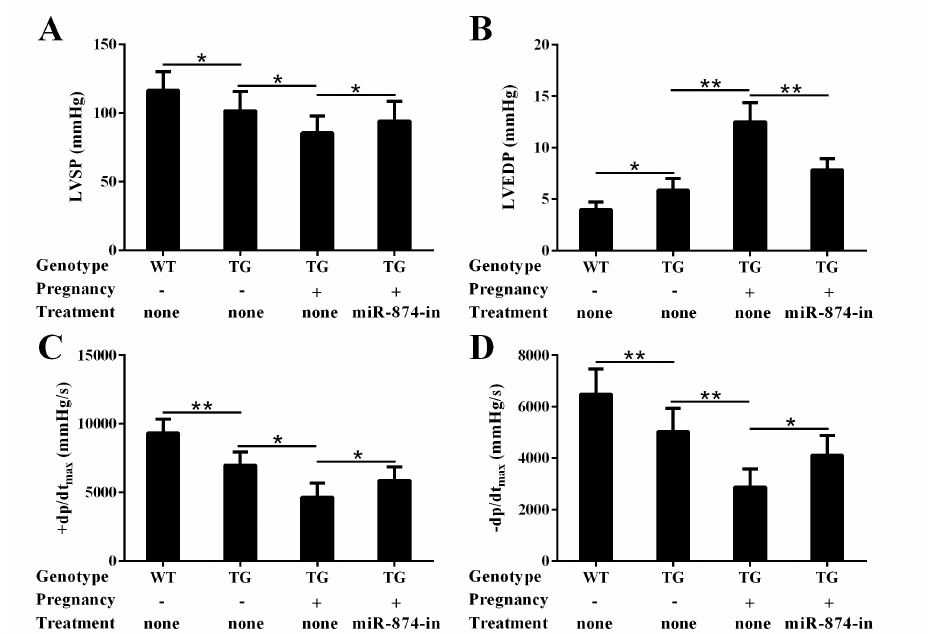
Figure 3. Analysis of left ventricular hemodynamics. LVSP (A), LVEDP (B), +dp/dtmax (C) and -dp/dtmax (D) in survived mice from each group. Age-matched, female non-pregnant wild-type (WT, n=24) and Gαq transgenic mice (GT, n=24), pregnant Gαq transgenic mice (n=14) and Gαq transgenic mice treated with miR-874 antagonist (miR-874-in, n=21) were compared. Data are presented as mean ± SD. *p < 0.05, **p < 0.01 between the indicated groups. LVSP: left ventricular systolic pressure, LVEDP: left ventricular end-diastolic